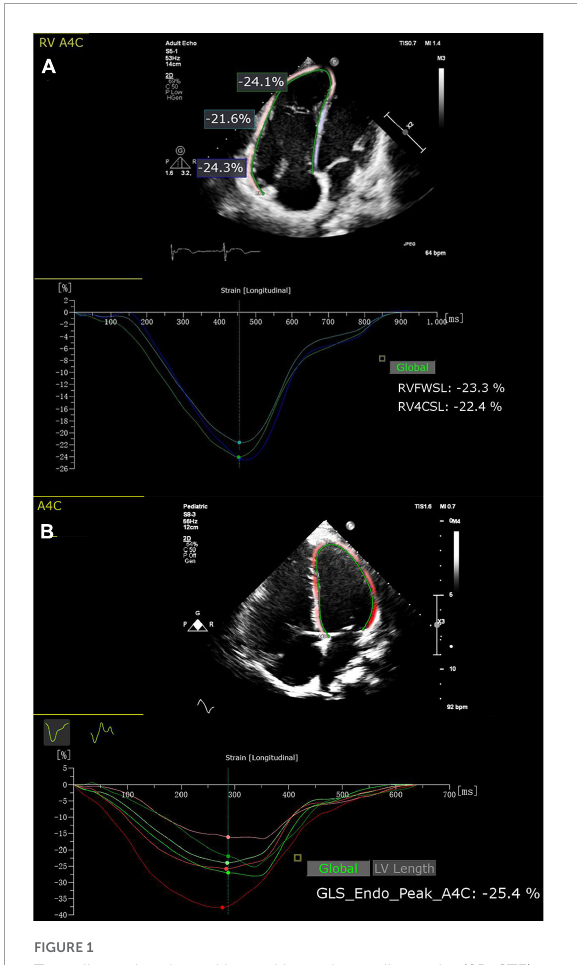
FIGURE1 Two-dimensional speckle tracking echocardiography (2D-STE) offline analysis for RVFWLS (A) , RVGLS (A) and LVGLS (B) . RVFWSL, right ventricular free wall longitudinal strain; RV4CSL, right ventricular global longitudinal